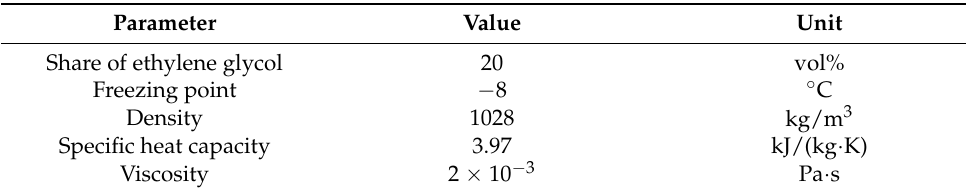
Table 2. Physical properties of the used water-ethylene glycol mixture at a reference temperature of 10 ◦ C, own representation according to [16]. Parameter Value Unit Share of ethylene glycol Freezing point Density 1028 Specific heat